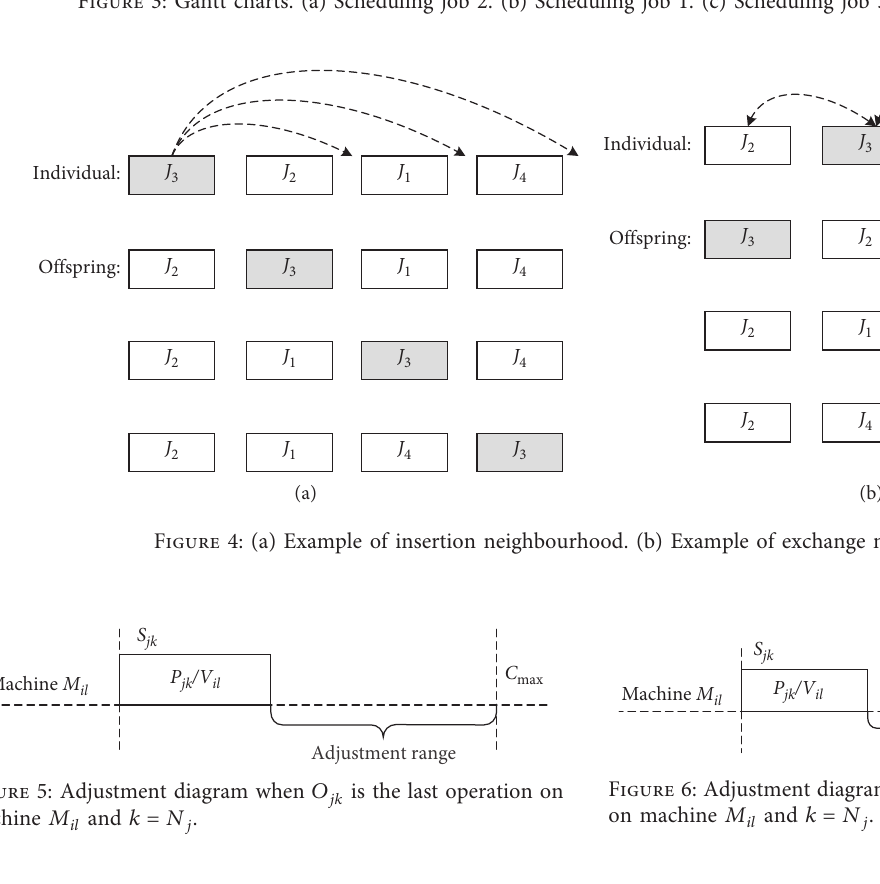
Figure 3: Gantt charts. (a) Scheduling job 2. (b) Scheduling job 1. (c) Scheduling job 3. (d) Scheduling job 4.